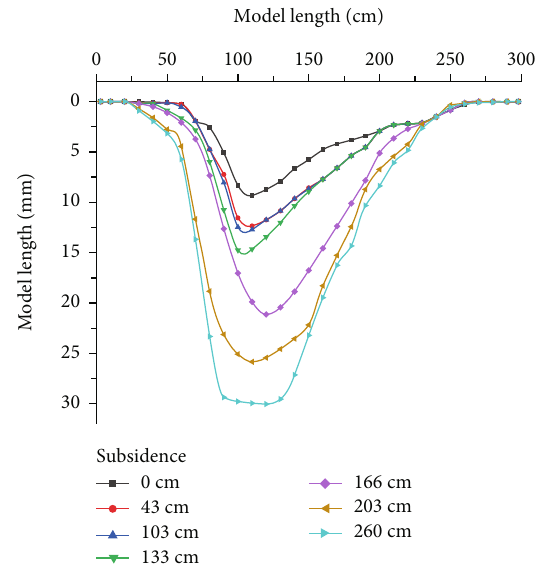
Figure 13: Subsidence characteristics of top of mining model of the 222 working